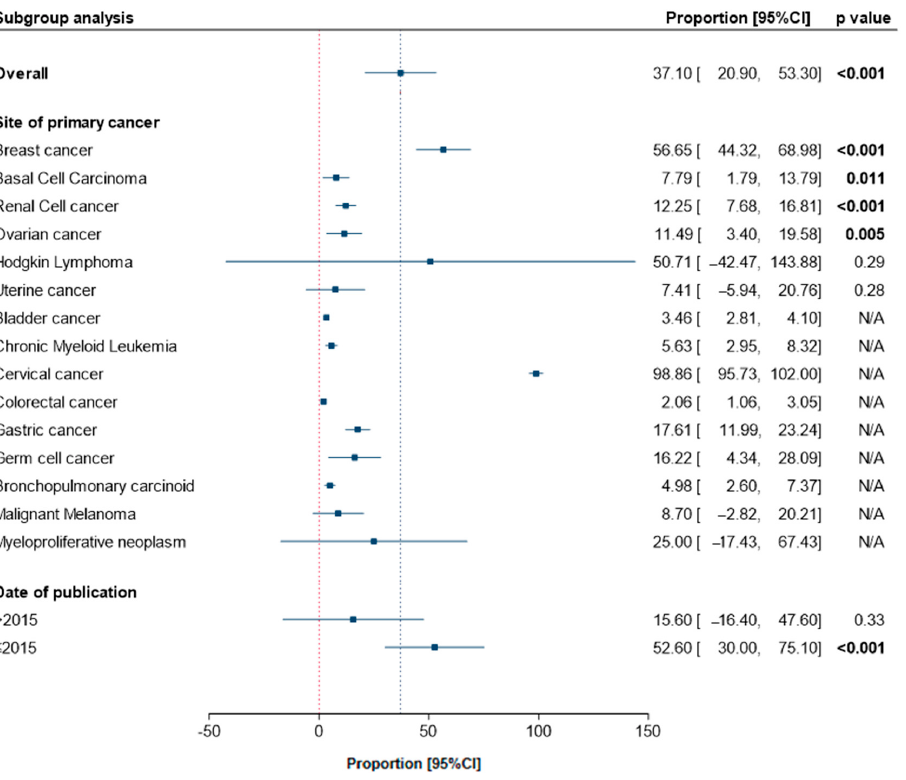
Figure 3. Pooled frequency of SPTC following a primary cancer. Overall and subgroup analysis are shown.